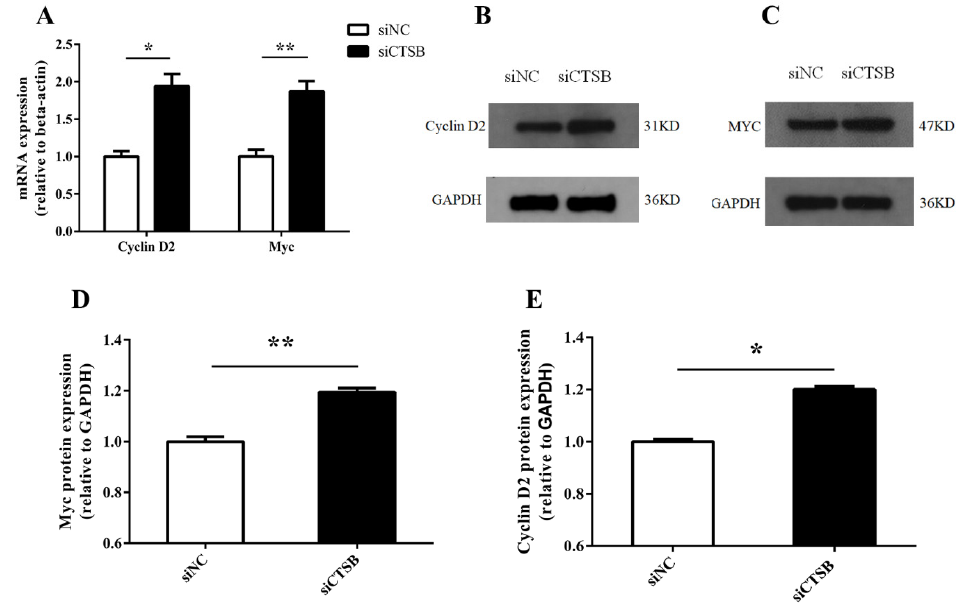
Figure 4. In vitro effect of CTSB depletion on expression levels (mRNA and protein) of proliferation and cell cycle marker genes in mouse GC. ( A ) Expression levels of Myc and cyclin D2 genes in GC transfected with siRNA and NC were determined by RT-qPCR against endogenous control β -actin . ( B – E ) siCTSB promoted the protein expression level of Myc and cyclin D2 in mouse GCs against an endogenous control GAPDH . The data were presented as means ± SEM of three independent experiments. Significant differences, * p < 0.05, ** p < 0.01; siCTSB, Cathepsin B siRNA; GC, granulosa cells; siNC, negative control siRNA.